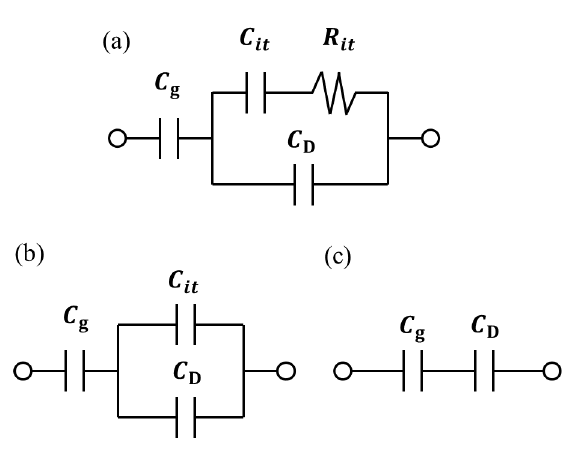
Figure 3: (a) Equivalent circuit of the impedance model (SRH model) of the MIS structure. (b) Equivalent circuit of tip–sample capacitance C LF in low-frequency KPFS with a low-frequency AC bias voltage. (c) Equivalent circuit of tip–sample capacitance C HF in high-frequency KPFS with a high-frequency AC bias voltage. C g : capacitance due to the tip–surface gap; C D : capacitance due to the depletion layer; C it : ca- pacitance due to interface states; R it : resistance due to interface